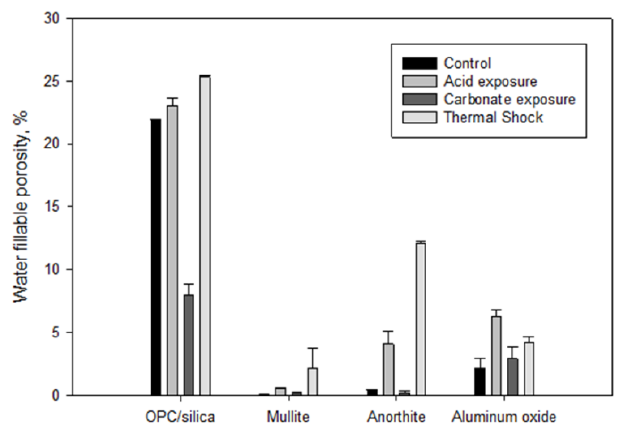
Figure 24. Water fillable porosity of different materials before and after imposed stress conditions. “Control” refers to the 250 °C autoclaved samples.